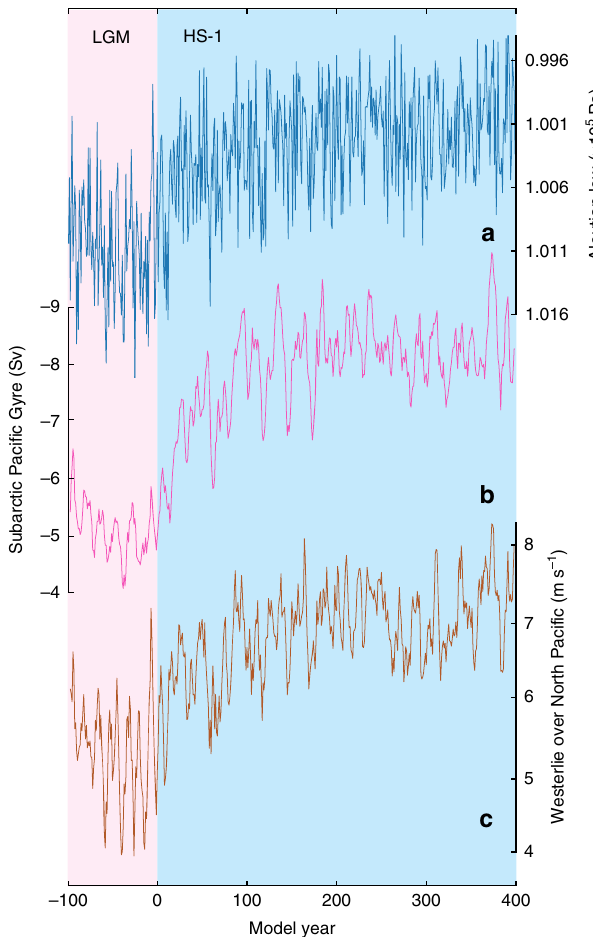
Fig. 3 Modelled surface atmosphere and ocean change in the North Paci fi c climate system. a Strength of the Aleutian Low, indexed by the regional minima of sea level pressures; b Strength of the subarctic Paci fi c gyre, indexed by the regional minima in stream functions; c . Strength of the Westerlies averaged between 30 and 50°N over the North Paci fi c